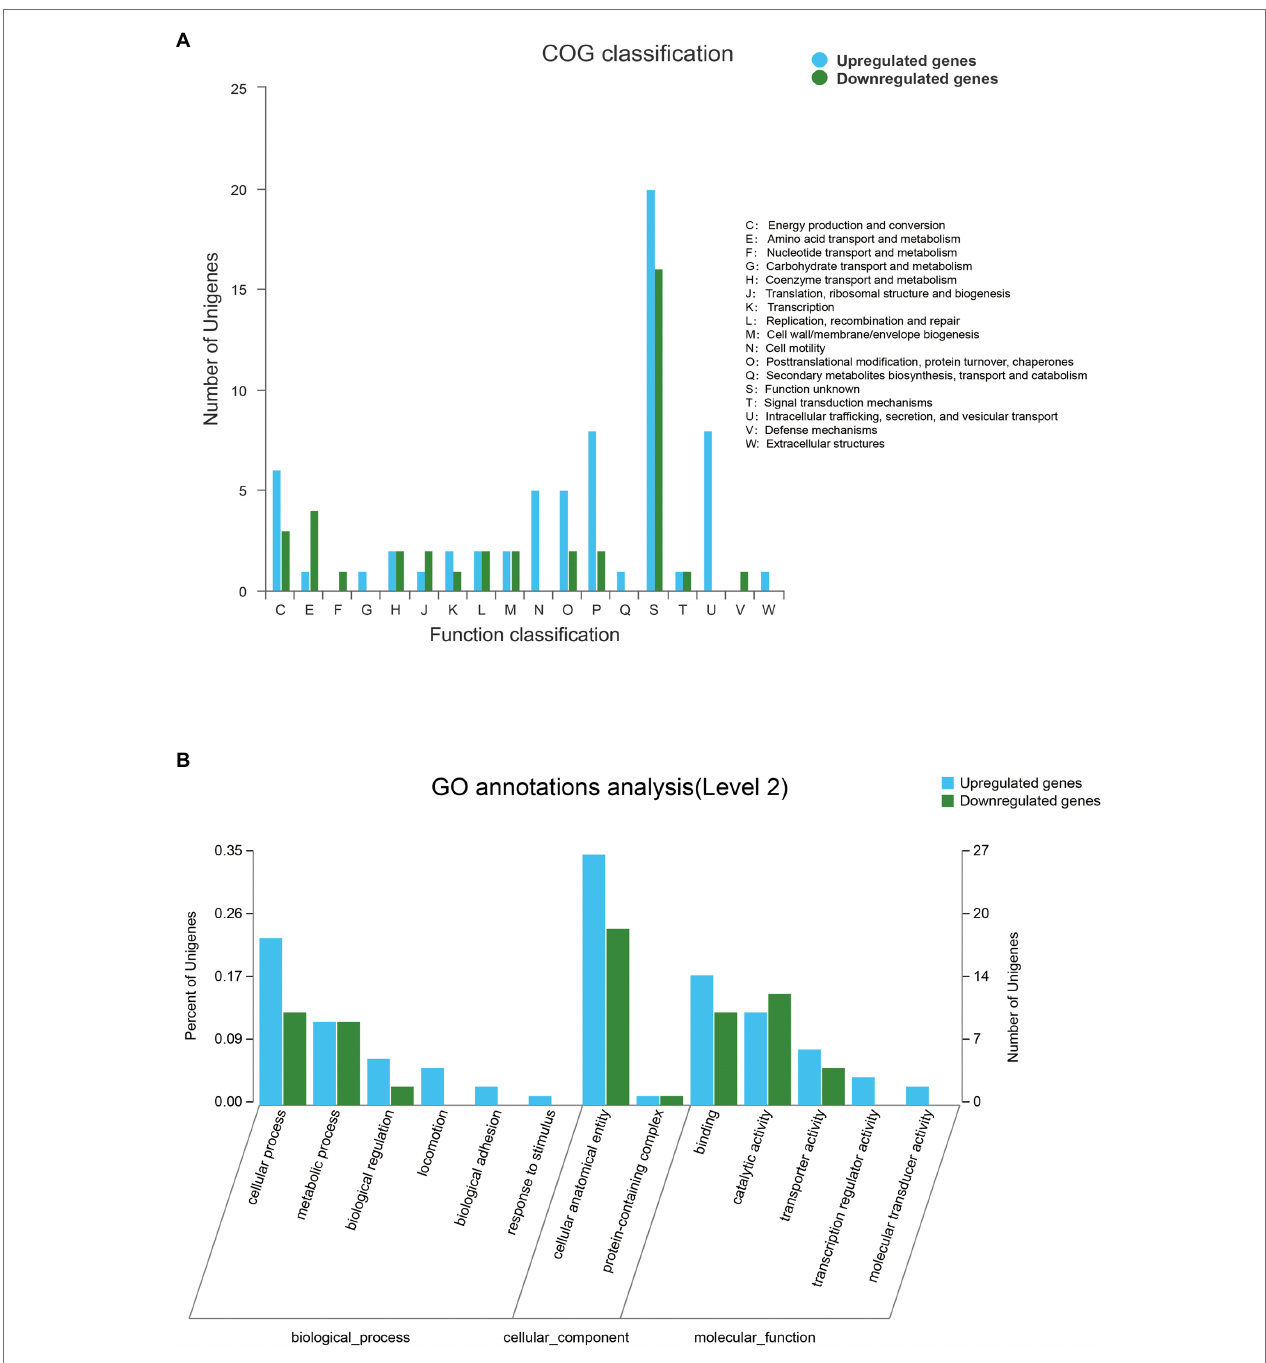
FIGURE 8 | (A) Distribution of differentially expressed genes (DEGs) between SMS and SMN in the cluster of COG. The X-axis represents the functional type of COG, and the Y -axis represents the number of genes. (B) Distribution of DEGs in Gene Ontology (GO) functional categories. The X-axis represents the secondary classification terms of GO, the Y -axis on the left represents the percentage of genes included in the secondary classification, the right represents the number of genes compared with the secondary classification, and the three colors represent the three major